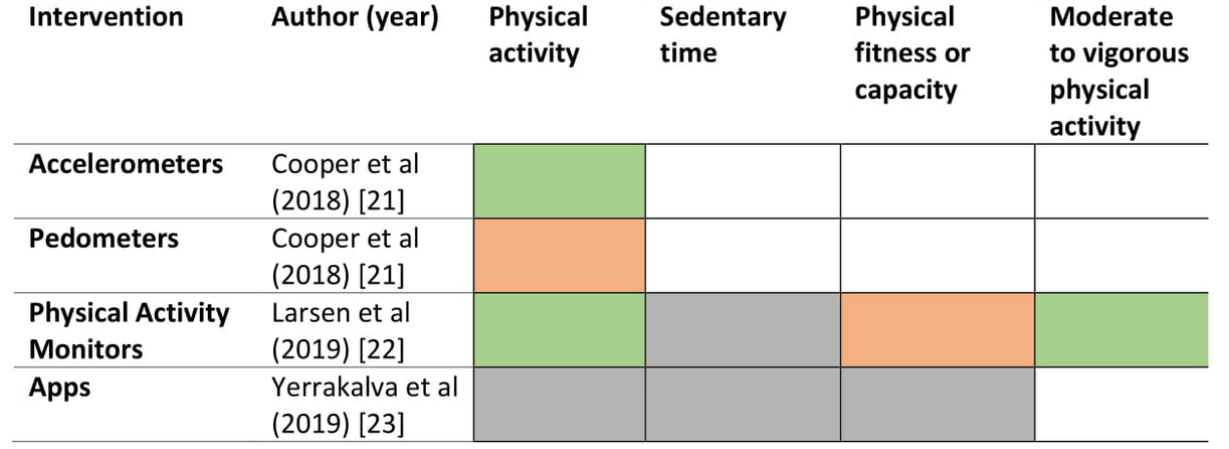
Figure 2. Summary of evidence from meta-analyses. Green indicates the intervention was effective, amber indicates there was no difference in the investigated comparison, grey indicates the evidence was inconclusive, and no color (blank) indicates the outcome was not